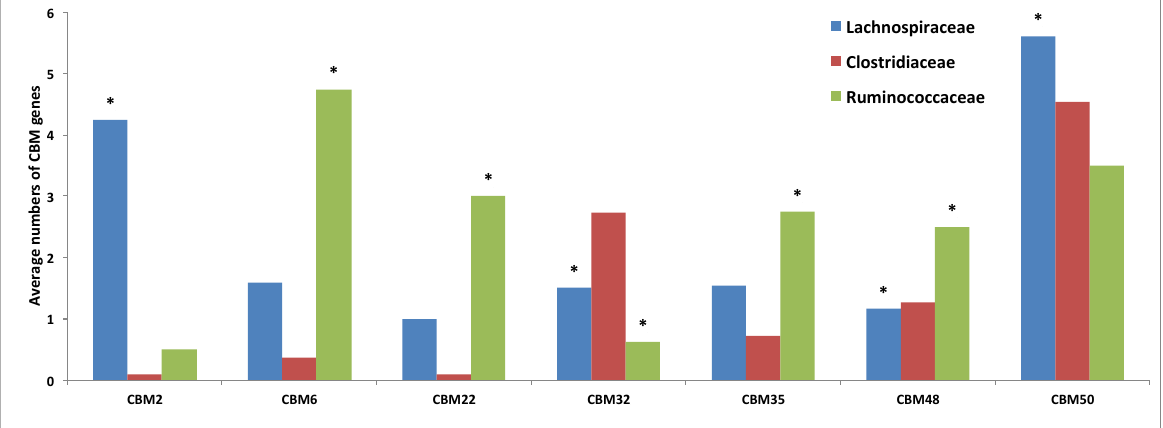
Figure 6. Carbohydrate-binding module (CBM) families with (*) significantly different patterns of abundance in the genomes of Lachnospiraceae, Clostridiaceae, and Ruminococcaceae based on best fit between negative binomial or Poisson regression models (Clostridiaceae as reference) as determined by likelihood ratio test ( p -value <